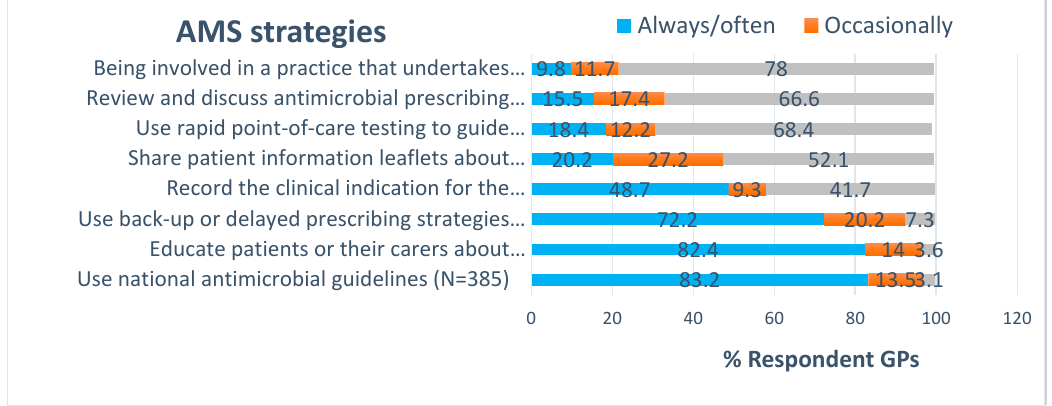
Figure 2. Proportion of GPs agreeing to uptake of AMS strategies when prescribing antimicrobials.